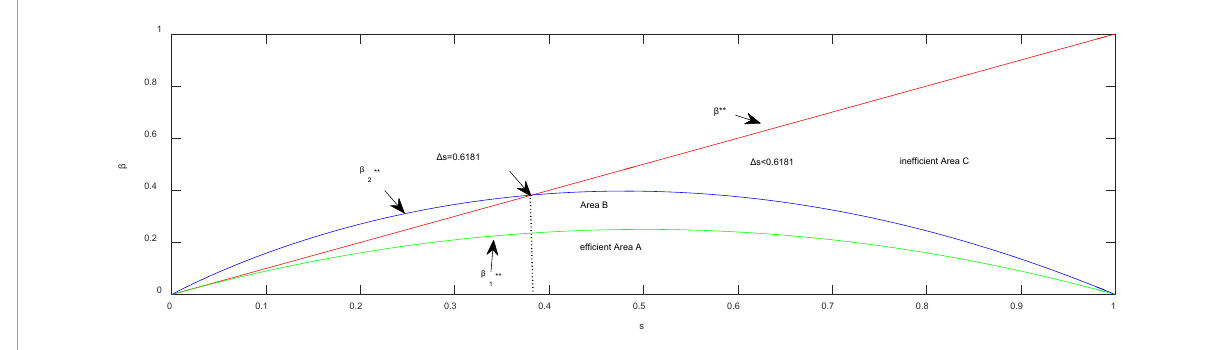
FIGURE1 Changes of efficient boundaries in quantity competition. **Thresholds of network